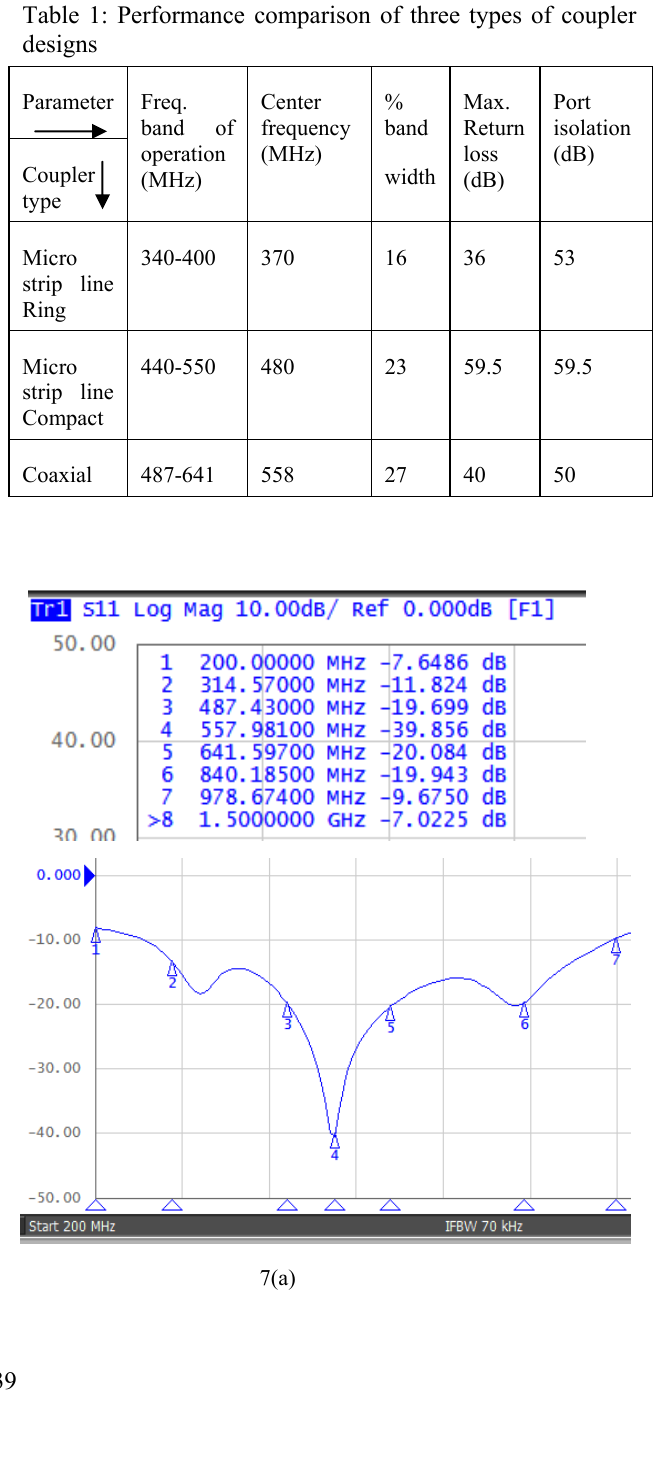
Table 1: Performance comparison of three types of coupler